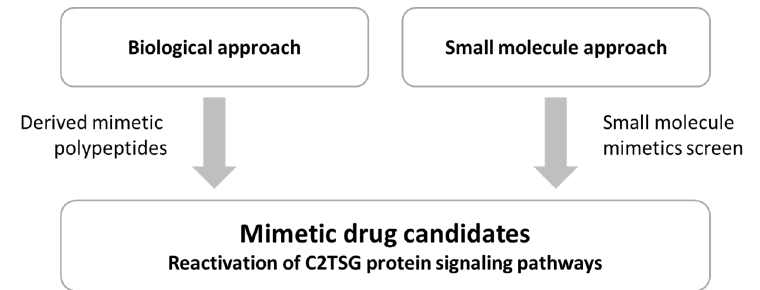
Figure 2. Biological and small molecule approach toward defining mimetic drug candidates able to reactivate the signaling pathway normally controlled by the C2TSG protein. Restoration of these growth suppressive signaling pathways should have a significant inhibitory effect on tumor initiation and progression.